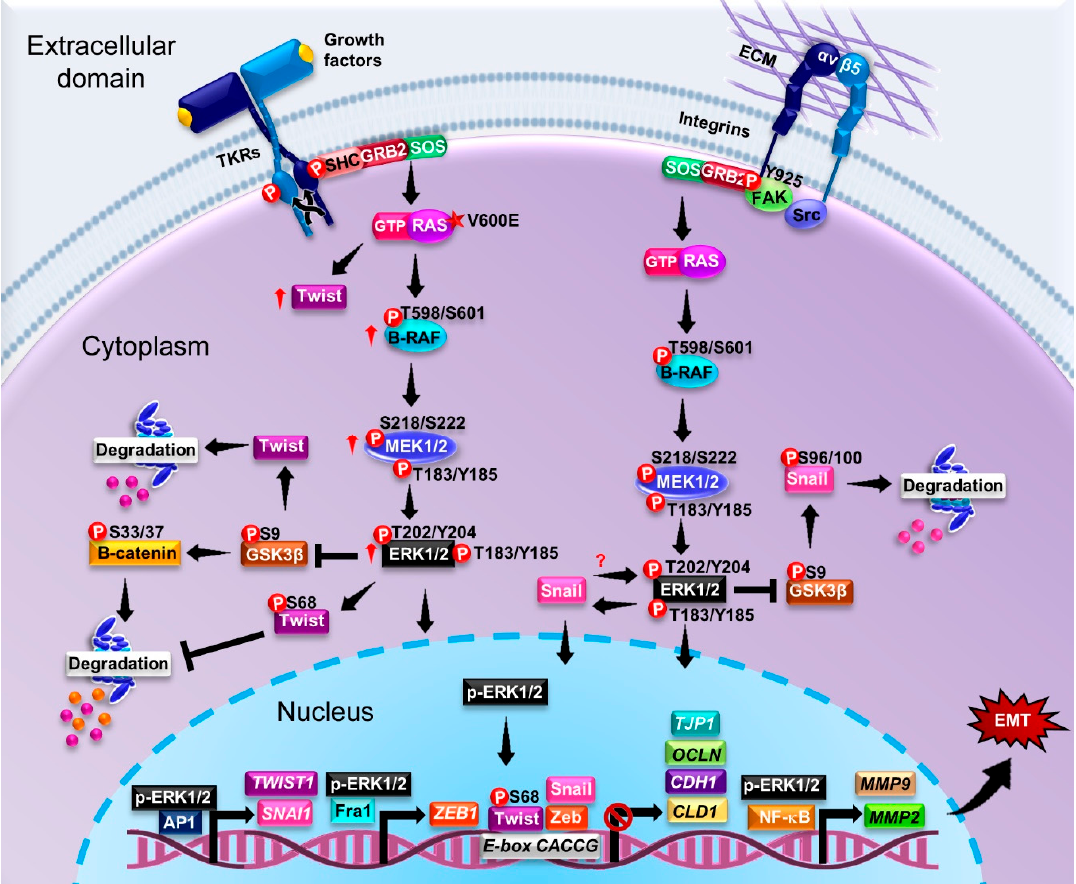
Figure 4. Relationship between ERK signaling and epithelial–mesenchymal transition (EMT)-associated transcription factors.